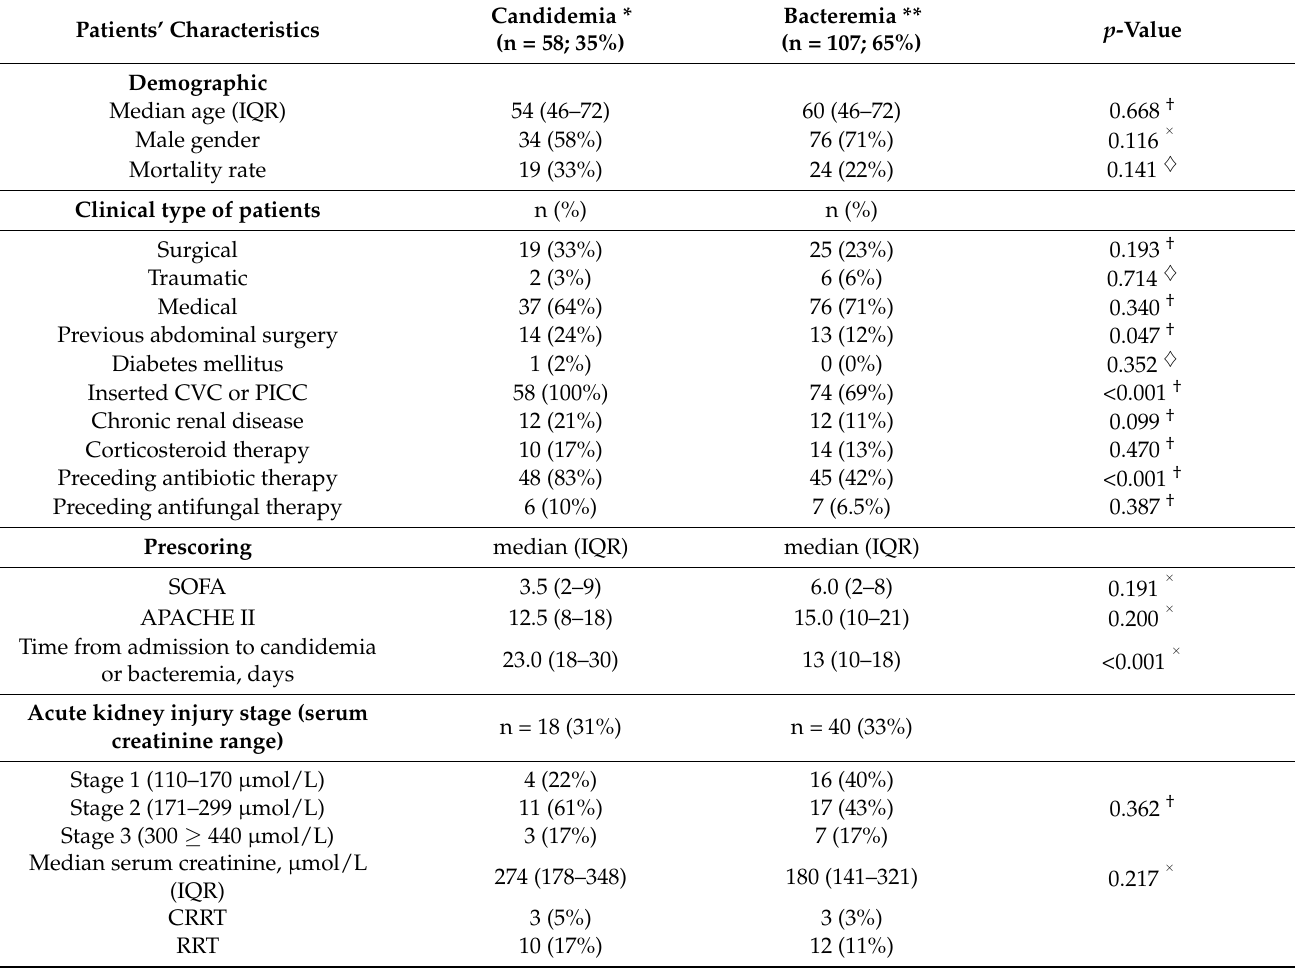
Table 1. Patients’ characteristics (n = 165). p -values indicate the significance of the difference between the candidemia and bacteremia groups for each variable at the time of